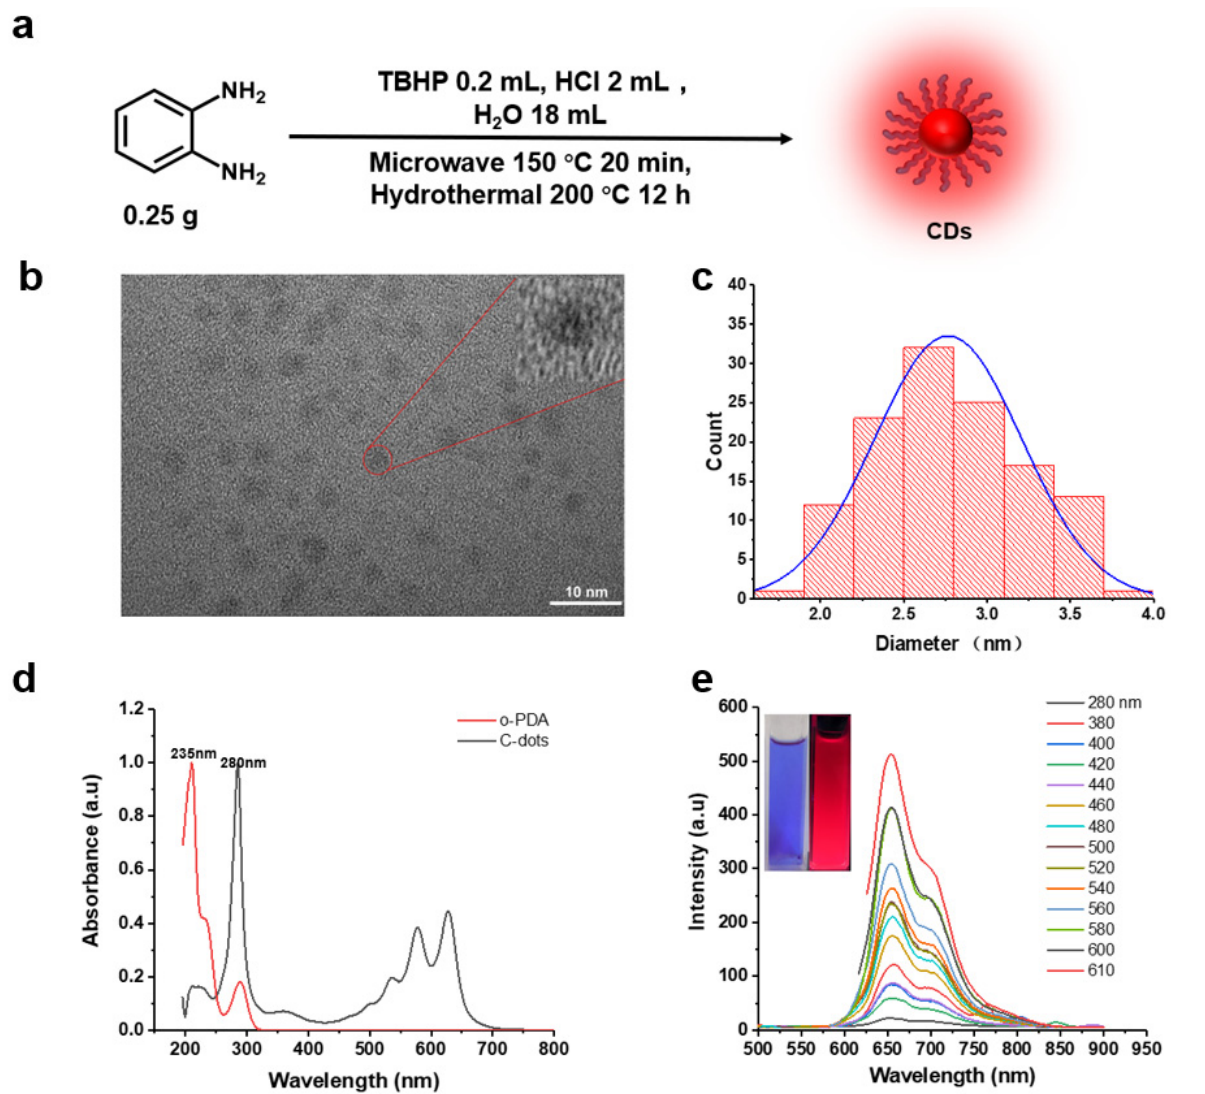
Figure 2. ( a ) Synthesis route of C-dots. ( b ) TEM image (the inset is an enlarged view of a particle) of the C-dots particles. ( c ) Size distribution histogram of C-dots. ( d ) UV–vis spectral of C-dots vs. the carbon precursor o-PDA. ( e ) PL spectral of C-dots excited at various wavelengths. The inset: Photographs of C-dots under ambient light (left) and 365 nm handheld UV light (right).